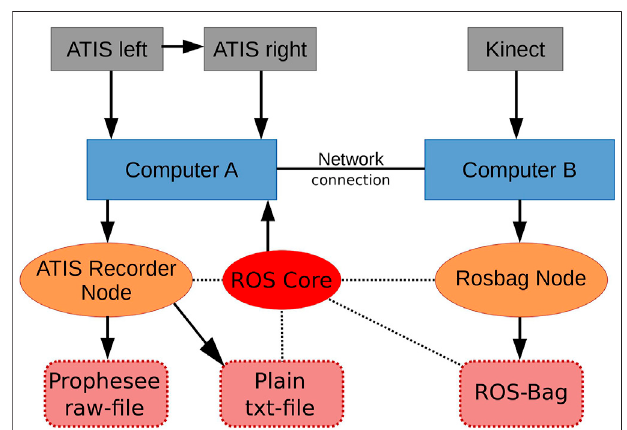
FIGURE 1 | Recording setup consisting of three sensors (gray), two computers (blue), the ROS core (red), the two recorder ROS-nodes (orange) and the different data structures (dark red). The arrows represent direct data transfer while dashed lines symbolize which structures are synchronized via the roscore ’ s